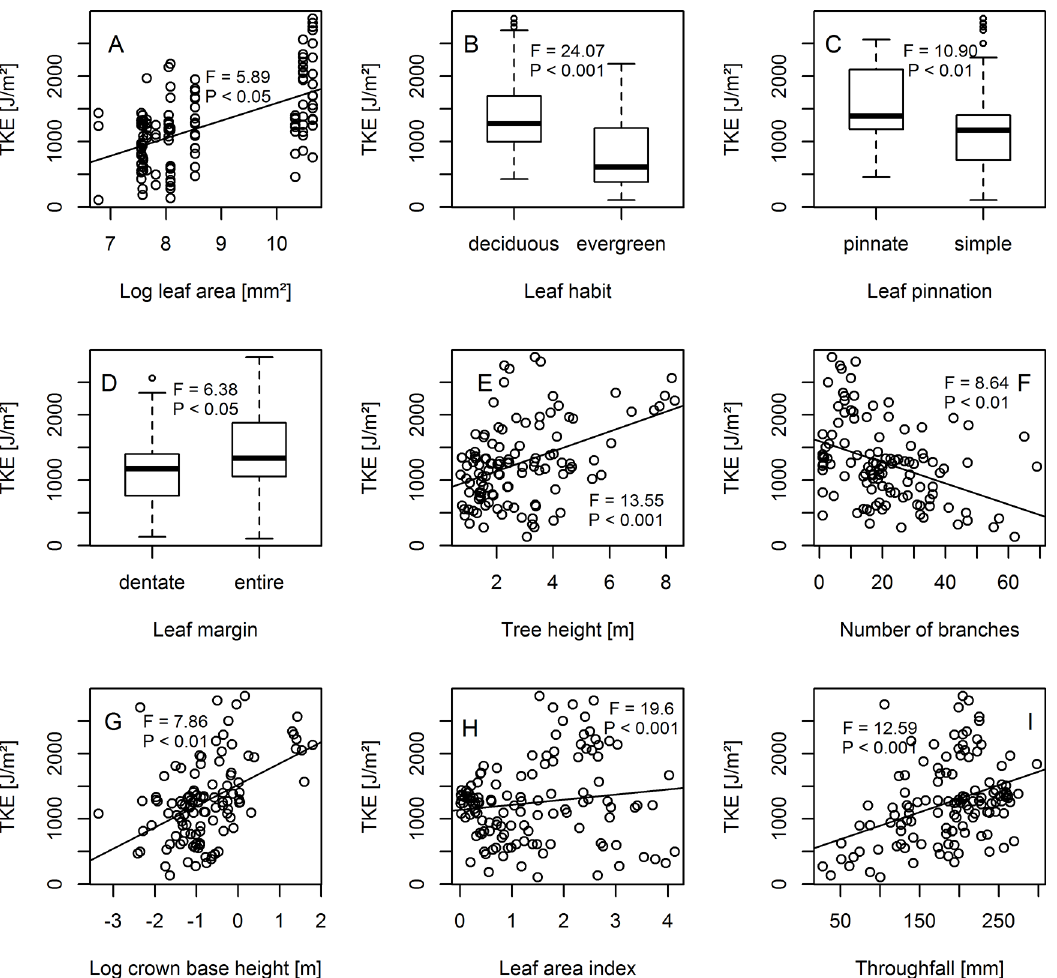
Fig 2. Throughfall kinetic energy (TKE) versus leaf traits (A-E), tree architectural traits (F-H) and abiotic covariates (I). Black solid lines indicate linear trend.